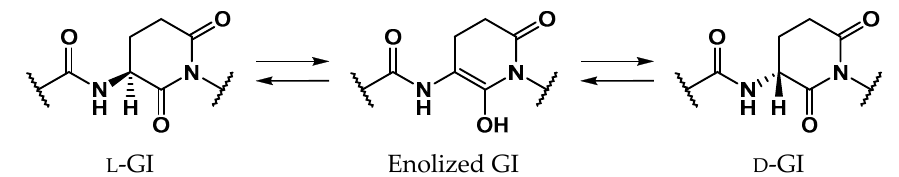
Scheme 4. Proposed GI-intermediate stereoinversion mechanism via enolized GI intermediates